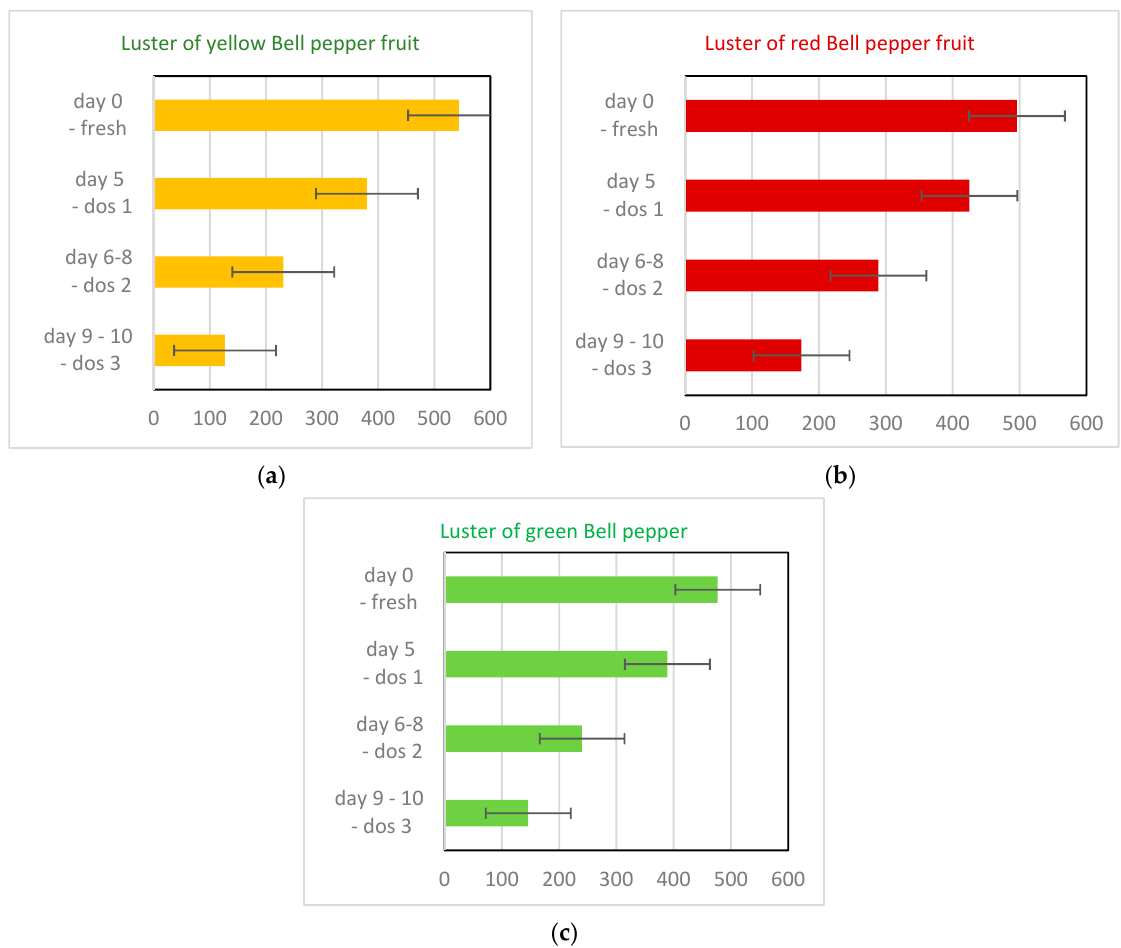
Figure 4. First Freshness index of Bell pepper fruit classified by fruit colour, yellow ( a top-left), red ( b middle) and green ( c bottom), averaged gloss values, stored over 14 days with the degree of shrivel (d.o.s) ( n = 60 pepper fruit per day; ± SD).